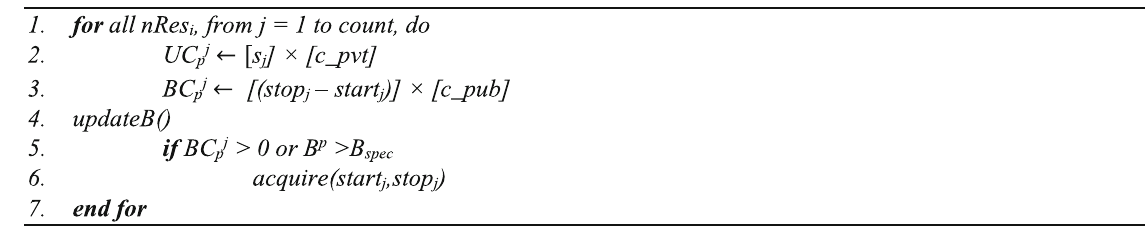
Table 3 Proactive Auto-Scaling Algorithm (Part